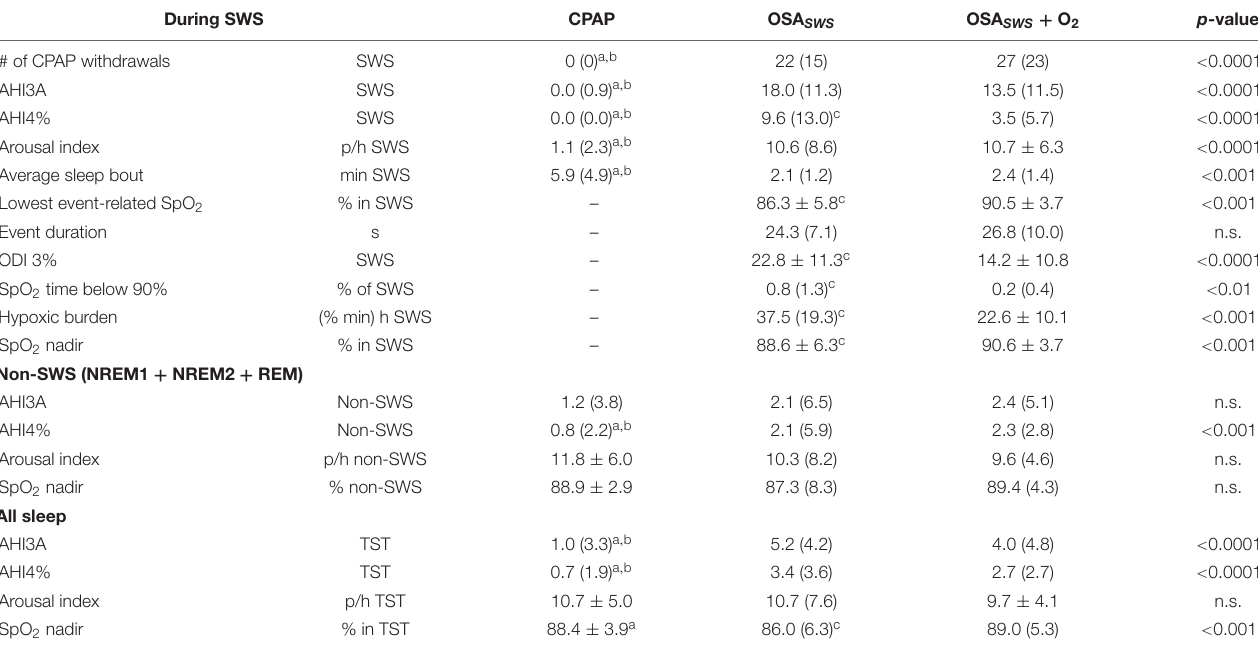
TABLE 2 | Obstructive sleep apnea (OSA) severity, sleep fragmentation, and intermittent hypoxemia. During SWS